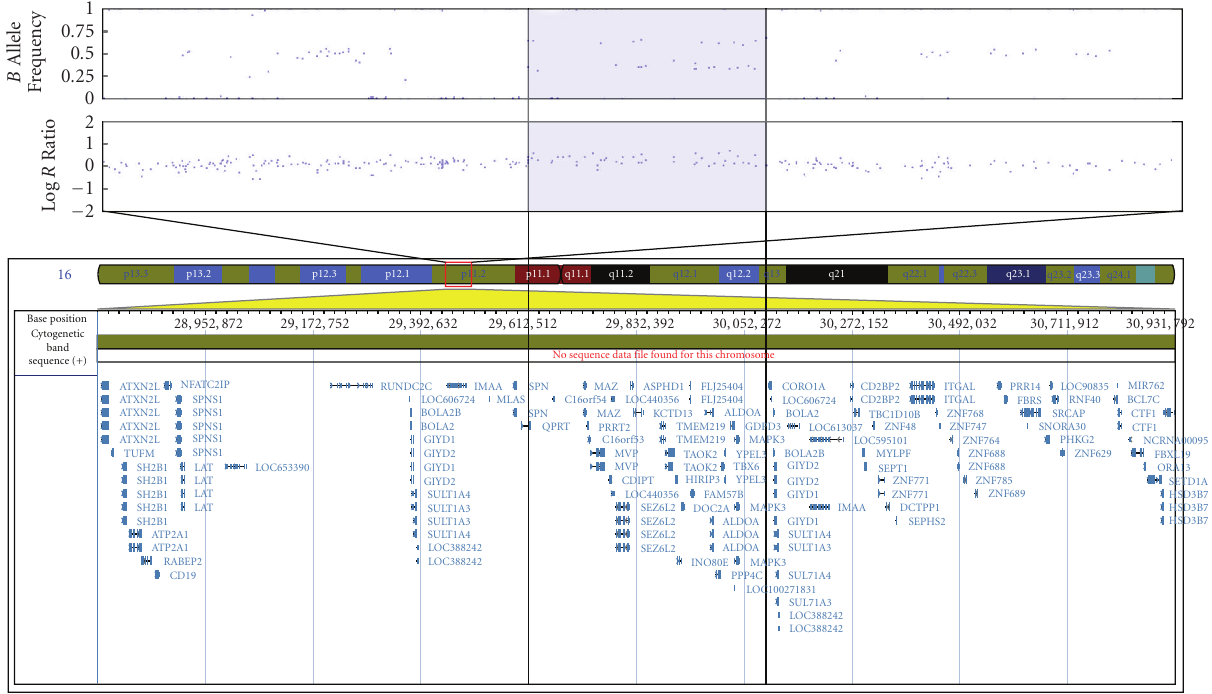
Figure 2: Representative image of B Allele Frequency and Log R Ratio of the participant who had a duplication at 16p11.2. The purple- shaded portion indicates the duplicated region (Human Genome Build